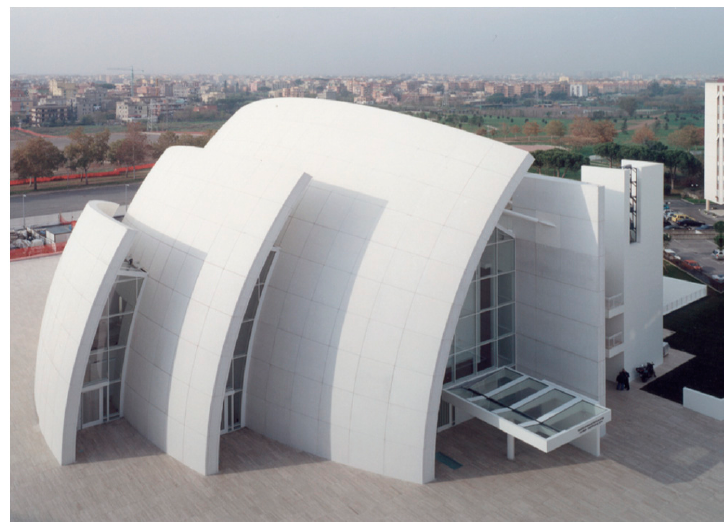
Figure 47. Dives in Misericordia Church, Rome, constructed of TiO 2 self-cleaning and depolluting TX Active cement (inaugurated in 2003). Reproduced from https://es.i-nova.net/content?articleId=96804 or https://www.archdaily.com/20105/church-of-2000-richard-meier.